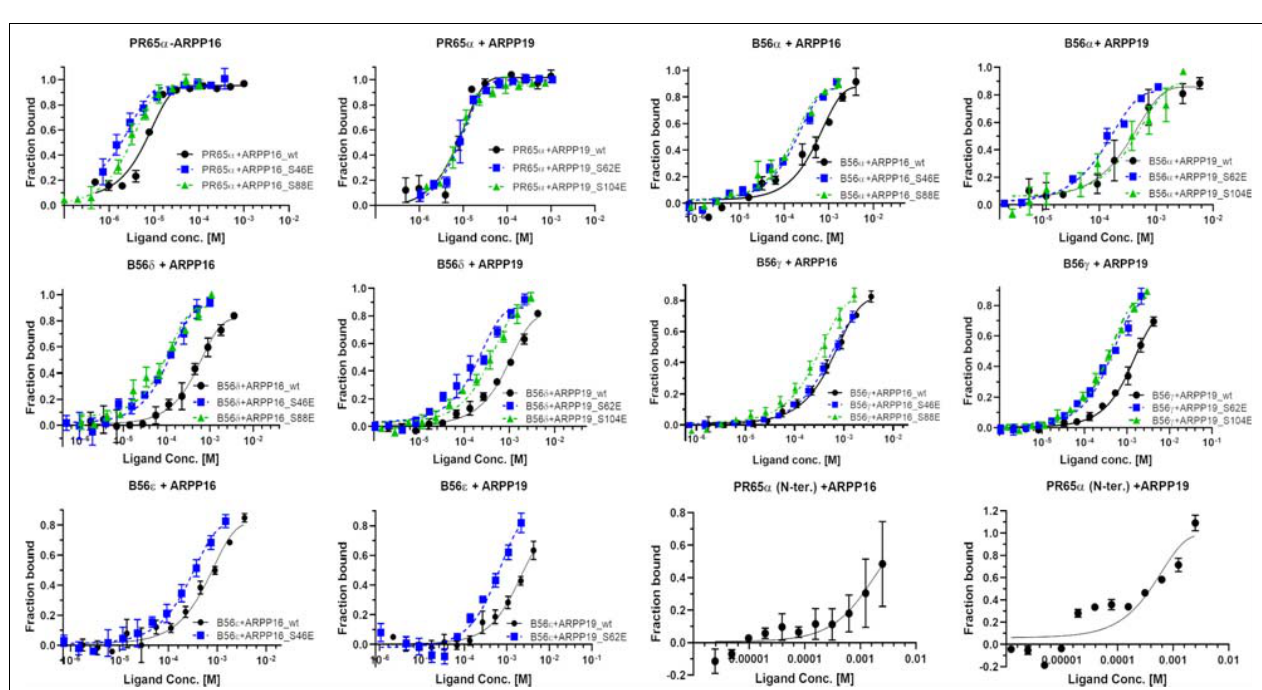
FIGURE 7 | The A-subunit provides a scaffold for ARPPs in PP2A whereas B56 subunits regulate the specificity. The binding curves obtained from MST experiments show that both ARPPs interact strongly with the scaffolding A-subunit. The interaction between WT and phosphomimicking mutants with the A-subunit is similar. The ARPPs interact in different way with various B56 isoforms, and the strength of the interactions is dependent on the phosphorylation state and site. MST measurements were performed using fluorescent labeled A- or B56 subunit as a target and unlabeled ARPP as a ligand.